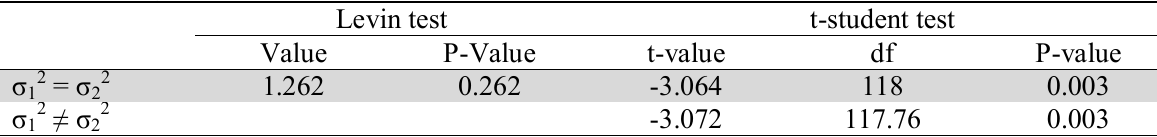
The summary of t-student and Levin